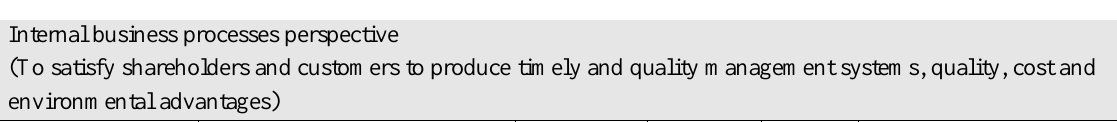
Table 3. Evaluated BSC from an internal process perspective Internal business processes